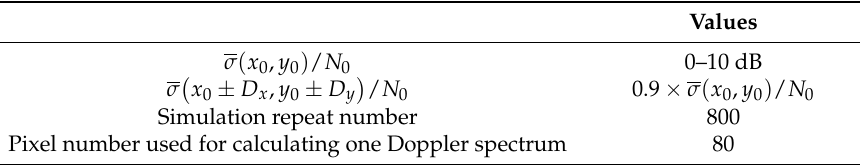
Table 4. Simulation parameters.